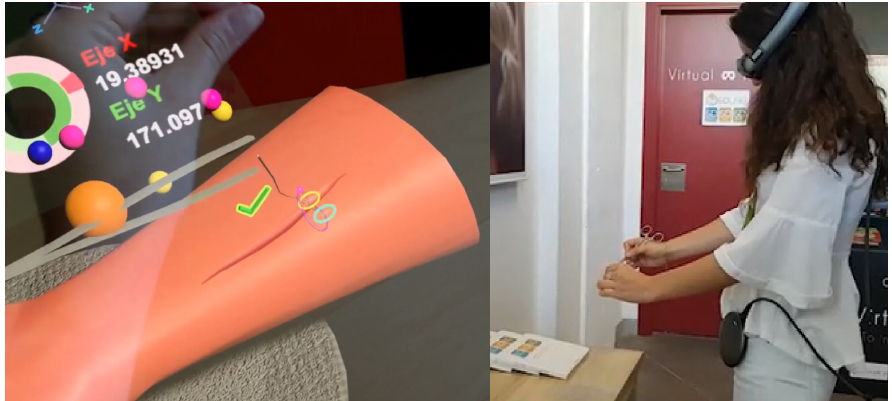
Figure 2. Participant testing Suture MR in Magic Leap device. The left image shows the augmented environment displayed on Magic Leap. The right image shows user’s performance during the interactive